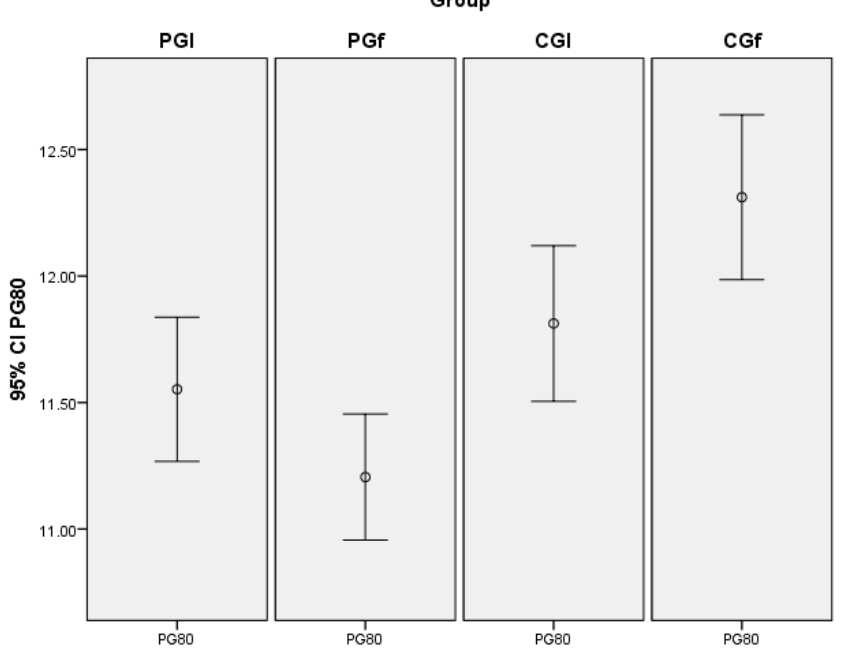
Figure 2. Speed 80 m means between the PG and CG groups.